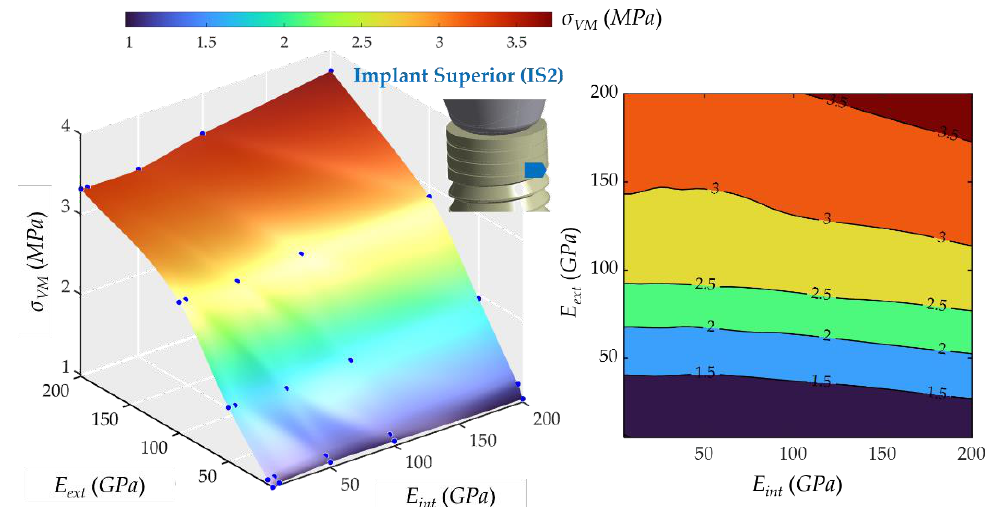
Figure 10. Von Mises maximum stress at the second upper part of the implant, implant superior 2 (IS2). ( Left ): 3D representation. ( Right ): vertical projection.